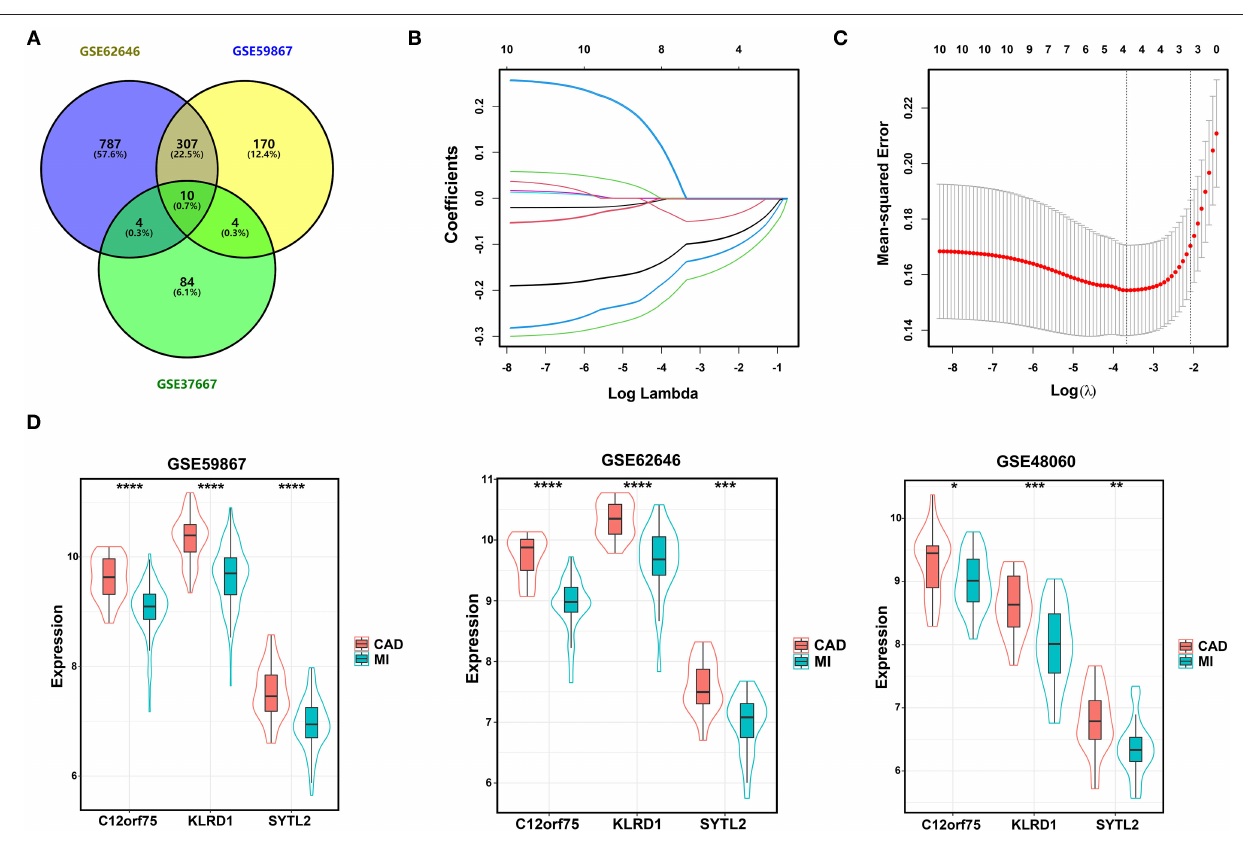
FIGURE 3 | Identification of diagnostic biomarkers for SD-related MI. (A) Venn diagram of two sets of MI-DEGs and a set of SD-DEGs. (B,C) LASSO coefficient profiles and LASSO deviance profiles. (D) The expression levels of three biomarkers identified by LASSO regression analysis between MI and CAD samples in the GSE59867, GSE62646, and GSE48060 datasets. * P < 0.05; ** P < 0.01; *** P < 0.001; **** P < 0.0001. MI, myocardial infarction; SD, sleep deprivation; CAD, coronary artery